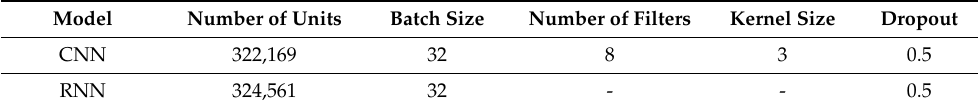
Table 5. The parameters of the training model CCN and RRN.